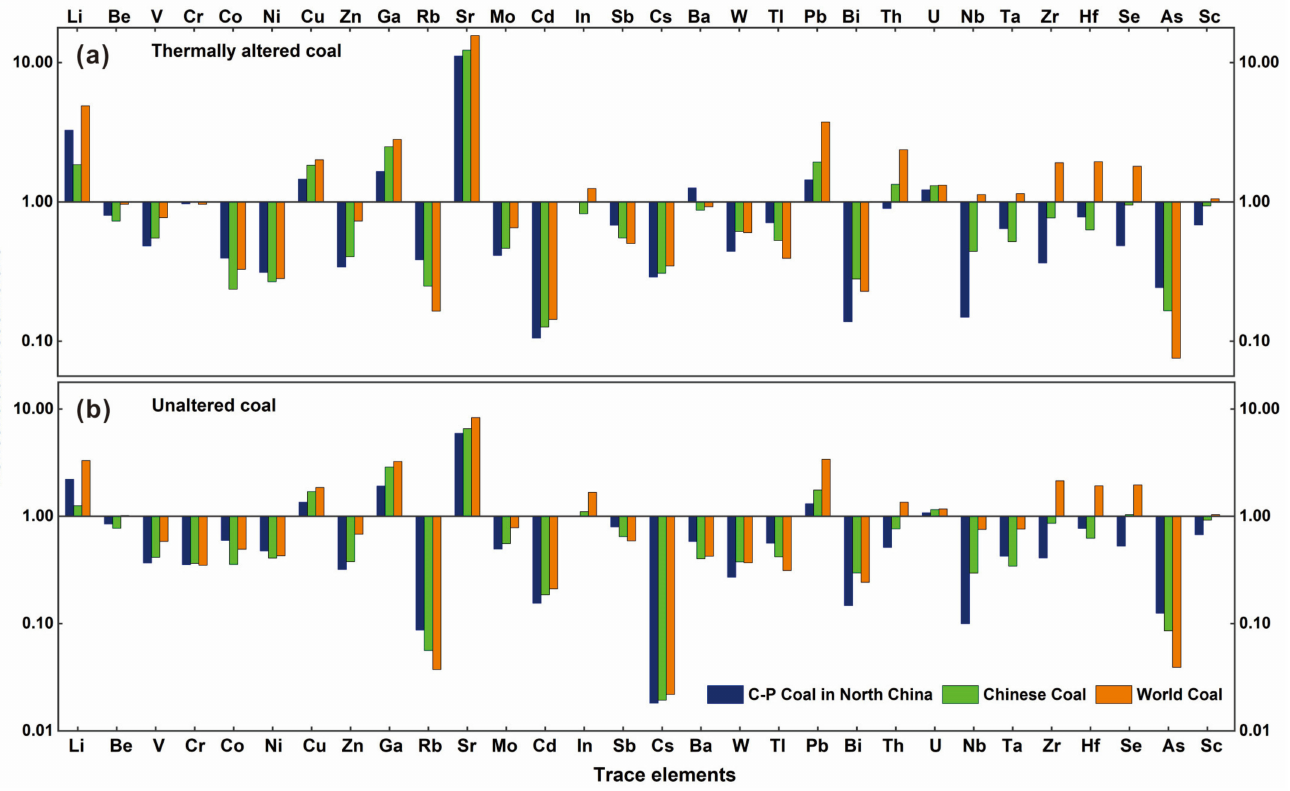
Figure 12. Concentration coefficients of trace elements in the Tashan coal: ( a ) the thermally altered coal; ( b ) the unaltered coal.